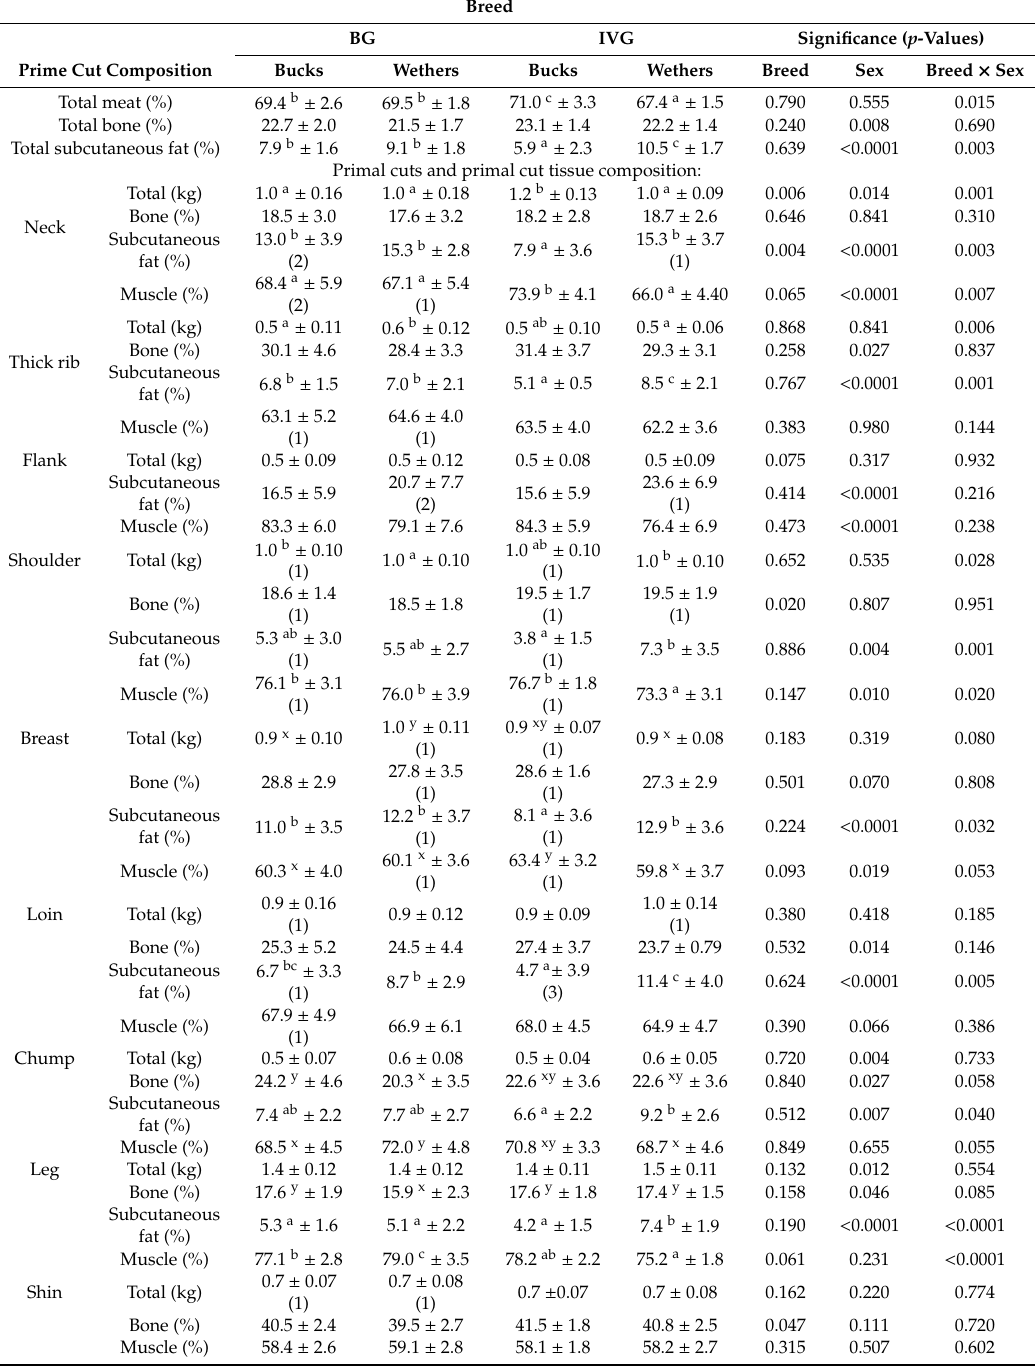
Table 2. Least-square means and standard error (SE) for proportions of tissue composition dissected (bone, subcutaneous fat and muscle as % of each primal cut) and comparison of yield means of primal cuts (kg) of Boer and large frame Indigenous Veld buck and wether goats (number of outliers removed indicated in